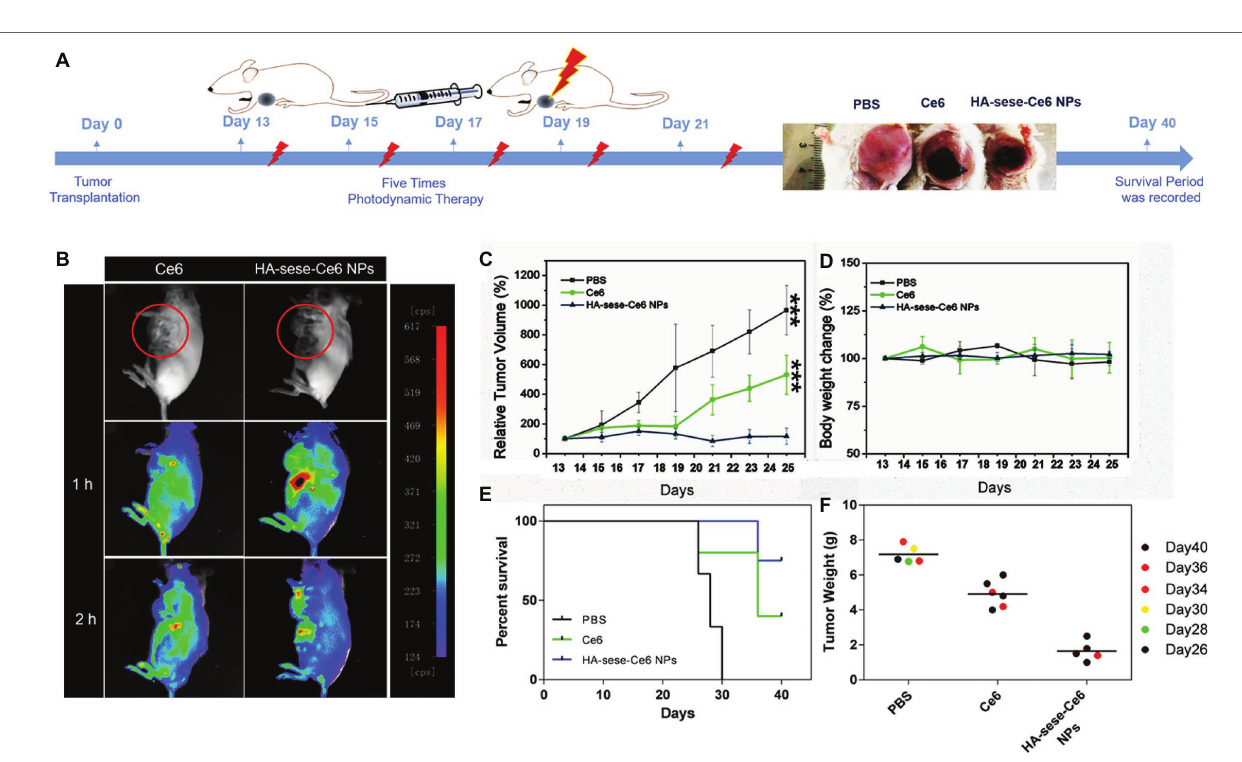
FIGURE 5 | (A) Photodynamic therapy scheme in a breast tumor animal model. (B) In vivo fluorescence imaging 1 and 2 h after the injections of free Ce6 and HA-sese-Ce6 micelles, respectively red circles represent tumor regions. (C) Tumor growth curves of mice in the free Ce6 and HA-sese-Ce6 micelles treated groups, and the PBS treated group served as the control. The data are mean ± SD, p *** ≤ 0.001 vs. the PBS. (D) The relative body weight changes in different groups. (E) The survival curve in PBS, Ce6, and HA-sese-Ce6 micelles groups. (F) Tumor weights of different groups were recorded on the day of natural death or execution (day 40).